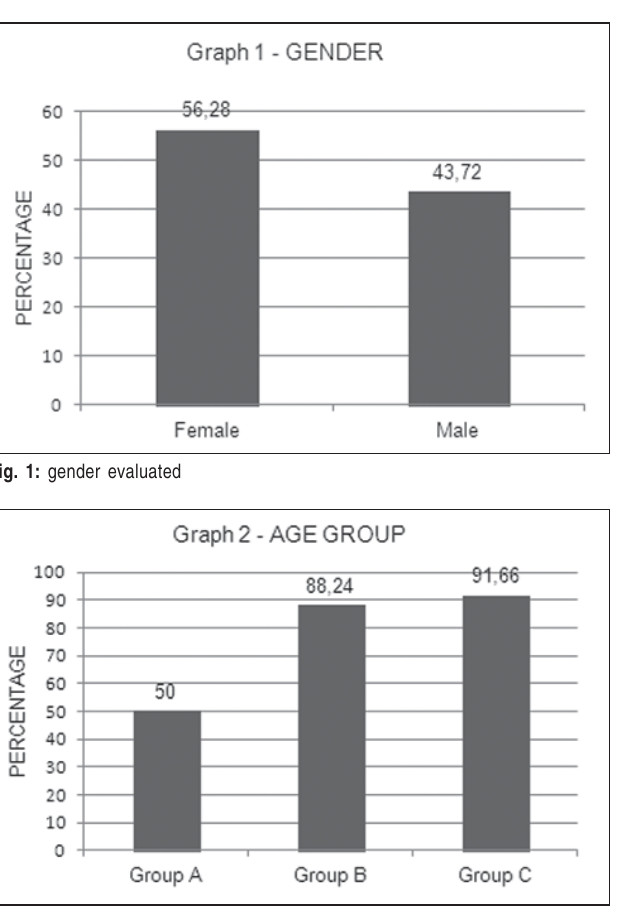
Fig. 2: age group